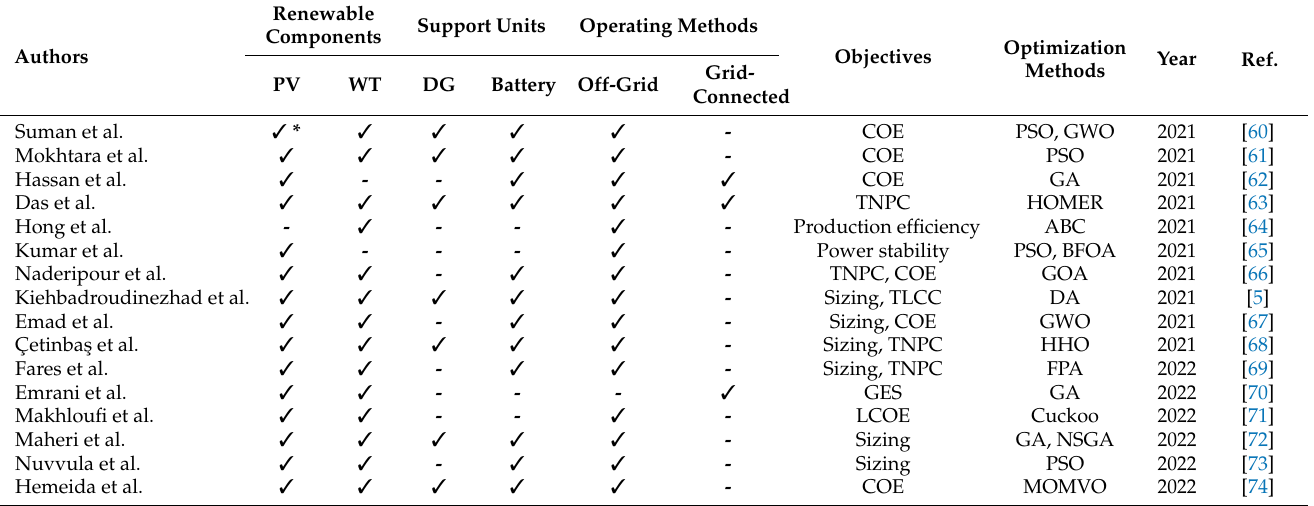
Table 4. A recent literature review on optimization techniques for hybrid renewable energy